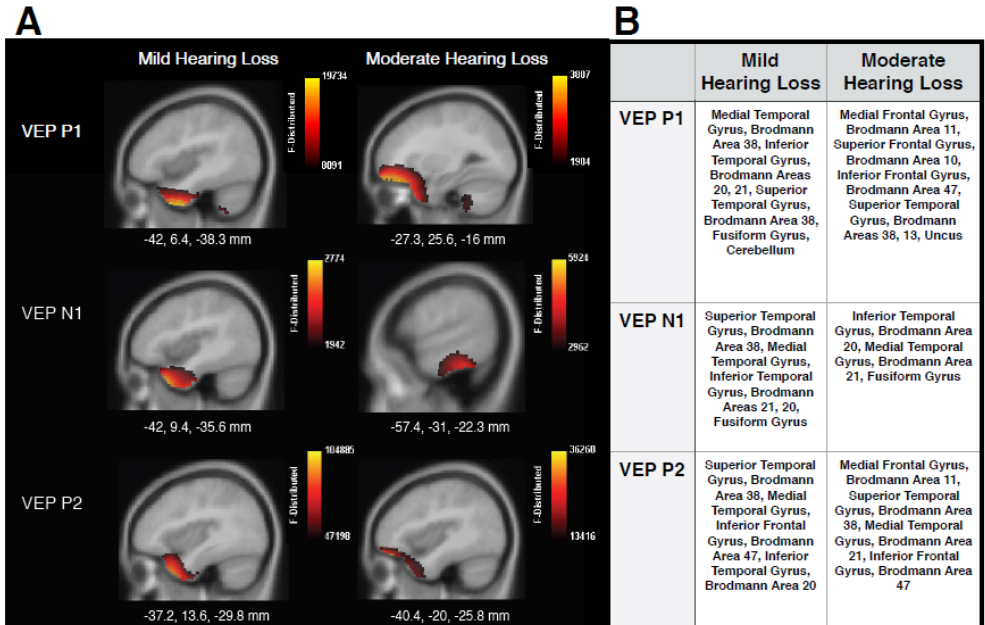
Figure 3. Current Density Reconstructions (CDR) . (A) CDR images illustrating cortical activation underlying VEP peak components P1, N1, and P1 on sagittal MRI slices for MILD ( n = 10) and MOD ( n = 7) hearing loss groups. The scale of the F distribution is shown in the upper right corner ranging from red (lowest level of activation) to yellow (highest level of activation), and Montreal